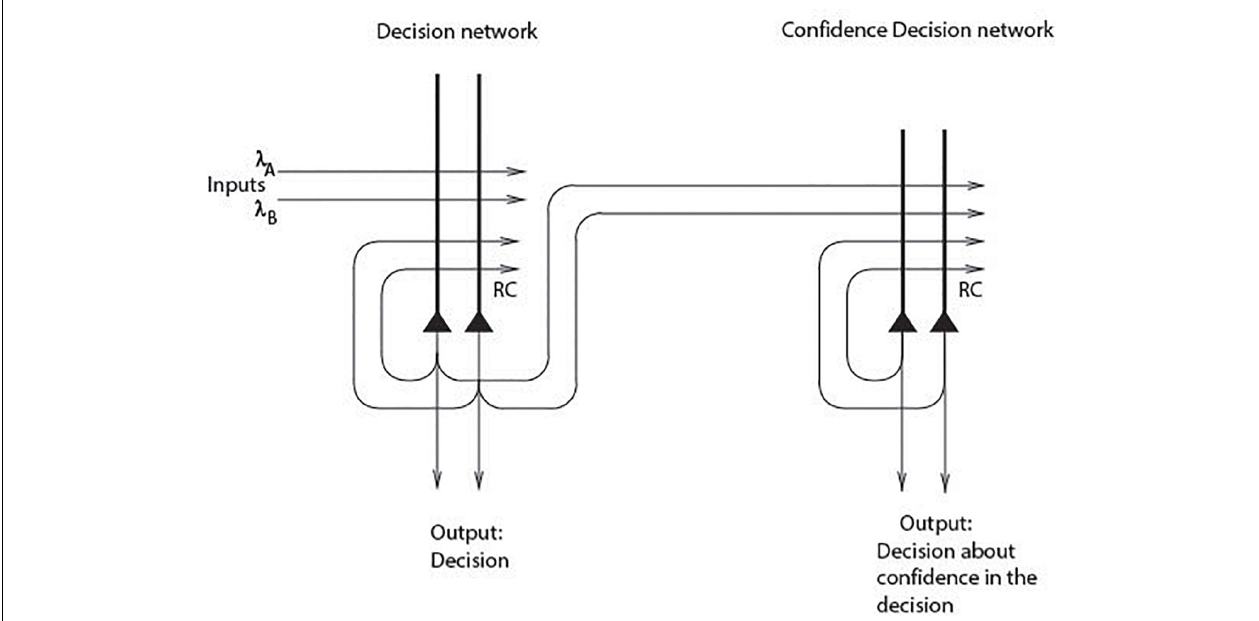
FIGURE 2 | Network architecture for decisions about confidence estimates. The first network is a decision-making network, and its outputs are sent to a second network that makes decisions based on the firing rates from the first network, which reflect the decision confidence. In the first network, high firing of neuronal population (or pool) DA represents decision A, and high firing of population DB represents decision B. Pools DA and DB receive a stimulus-related input (respectively λ A and λ B ), the evidence for each of the decisions, and these bias the attractor networks, which have internal positive feedback produced by the recurrent excitatory connections (RC). Pools DA and DB compete through inhibitory interneurons. The neurons are integrate-and-fire spiking neurons with random spiking times (for a given mean firing rate) which introduce noise into the network and influence the decision-making, making it probabilistic. The neurons in the winning population of the first network have a higher firing rate for confident decisions in which the difference between the decision variables is large (Rolls et al., 2010a; Rolls, 2016). The second network is a confidence decision attractor network, and receives inputs from the first network. The confidence decision network has two selective pools of neurons, one of which (C) responds to represent confidence in the decision, and the other of which responds when there is little or a lack of confidence in the decision (LC). The C neurons receive the outputs from the selective pools of the (first) decision-making network, and the LC neurons receive λ Reference which is from the same source but saturates at 40 spikes/s, a rate that is close to the rates averaged across correct and error trials of the sum of the firing in the selective pools in the (first) decision-making network. The second attractor network allows decisions to be made about whether to change the decision made by the first network, and for example abort the trial or strategy. The second network, the confidence decision network, is in effect monitoring the decisions taken by the first network, and